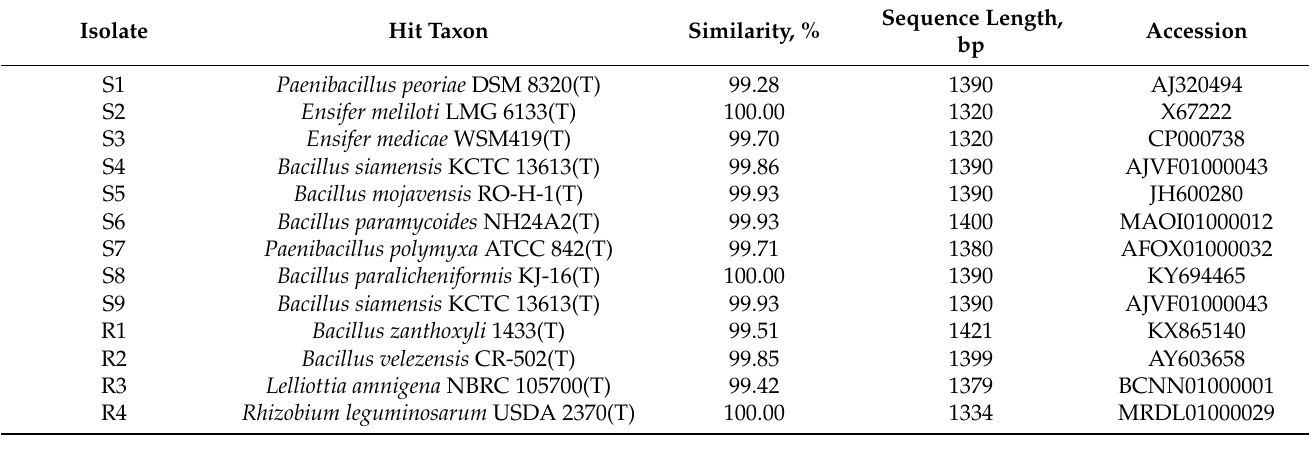
Table 3. Isolates’ BLAST analysis results.